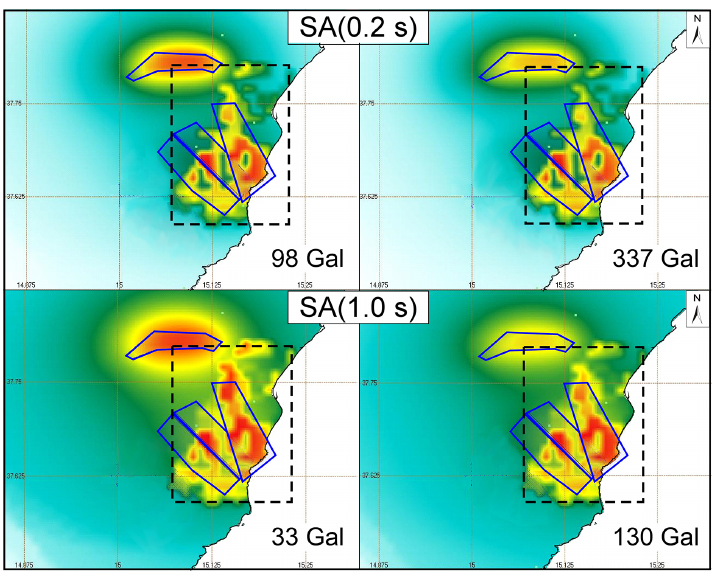
Figure 12. Site-specific hazard results of Level 1 (CRISIS). In the upper panels, the maps of SA 0.2s at 10% exceedance probability in 5 (left panels) and 50 years (right panels) are obtained for V s30 = 800ms − 1 for the whole area; the amplification factors are applied on a stripe on Mt. Etna southeastern flank (dashed black rectangle, see details in Figs. 7 and 8). The lower frames refer to SA